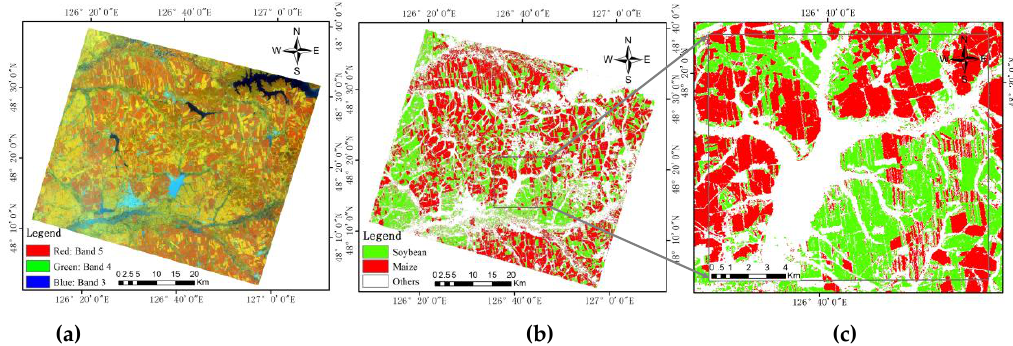
Figure 5. Reference classification result based on RapidEye image. ( a ) RapidEye image on July 27, 2014, ( b ) classification result based on RapidEye image, ( c ) partial magnification of classification result. The reference classification result is obtained by the unsupervised Iterative Self-Organizing Data Analysis (ISODATA) and visual interpretation approaches.